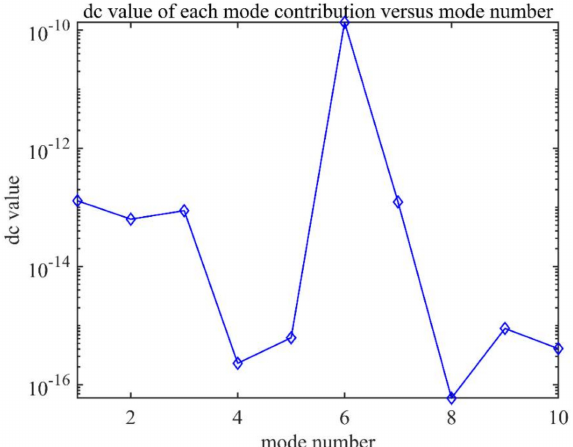
Figure 8. DC value of each mode contribution versus mode number.